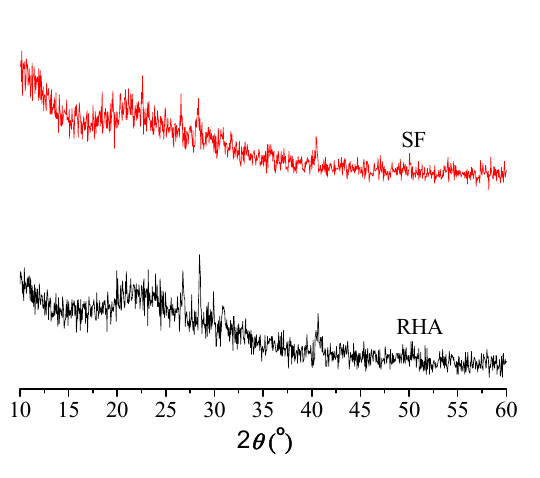
Figure 1. XRD spectrum of SF and RHA.